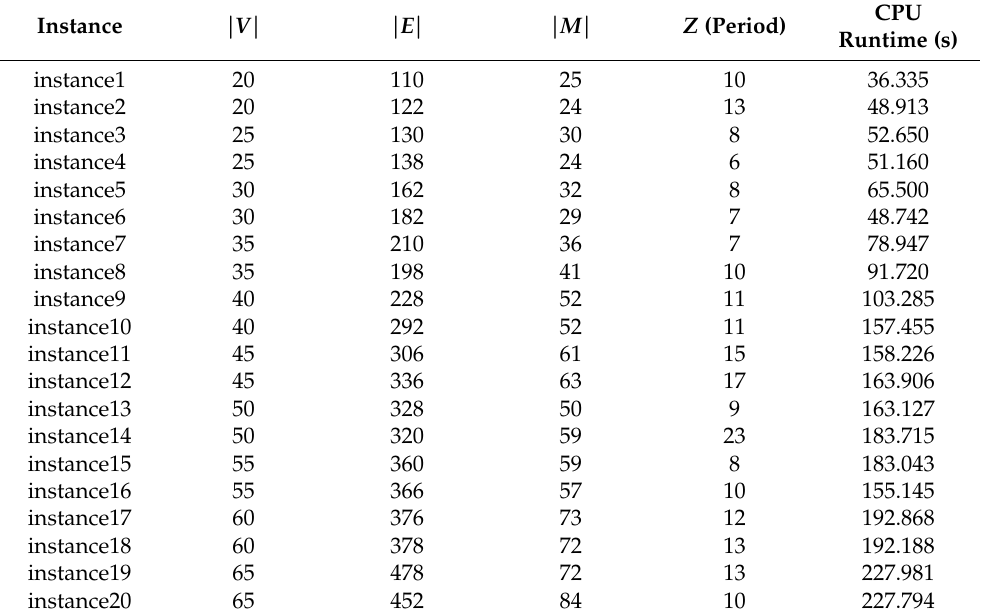
Table 3. Computational results of instances 1 to